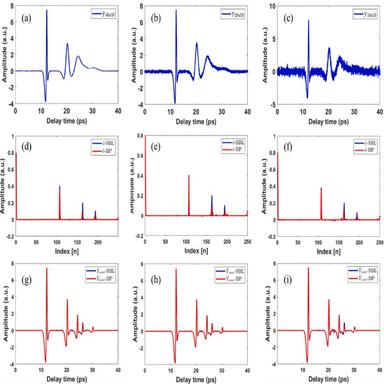
The spectrum localization results for the dispersive THz TOFT signals in (a) with different SNR by SBL and BP. (a)–(c) The dispersive THz TOFT signals with 40 dB, 20 dB and 10 dB, respectively; (d)–(f) The corresponding sparse weight vectors reconstructed by SBL and BP; (g)–(i) The corresponding dispersion compensation results by SBL and BP.